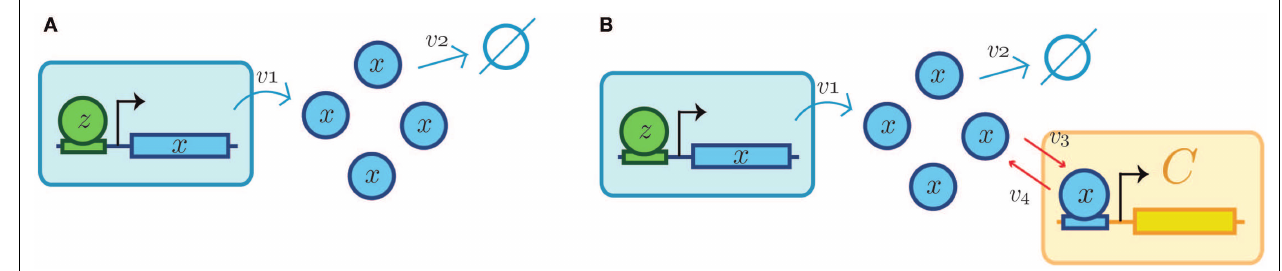
and dissociation rates, respectively). Here, v 3 denotes the loss in x species, which changes the upstream’s output concentration and thus its behavior. As mentioned in the main text, the retroactivity, and thus its potential to change behavior, depends on the number of downstream modules and the rates of association and dissociation. Here, the blue module would be equivalent to module A in Figure 1B and the yellow one would be analogous to the B one in Figure 1B . v 3 and v 4 play the role of x and s , respectively, in Figure 4C . The schematic representations are based on those used in Del Vecchio et al. and Sauro et al. Further details of how each of this systems aid retroactivity insulation are given in the main